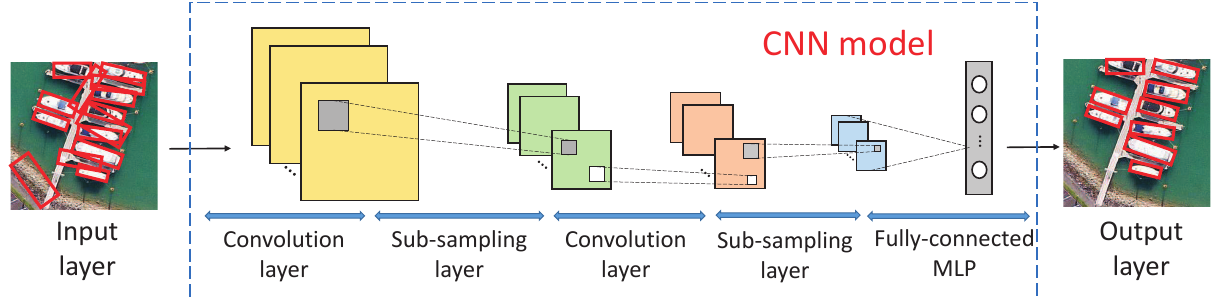
Figure 7: The flowchart of the CNN-based ship detection system.